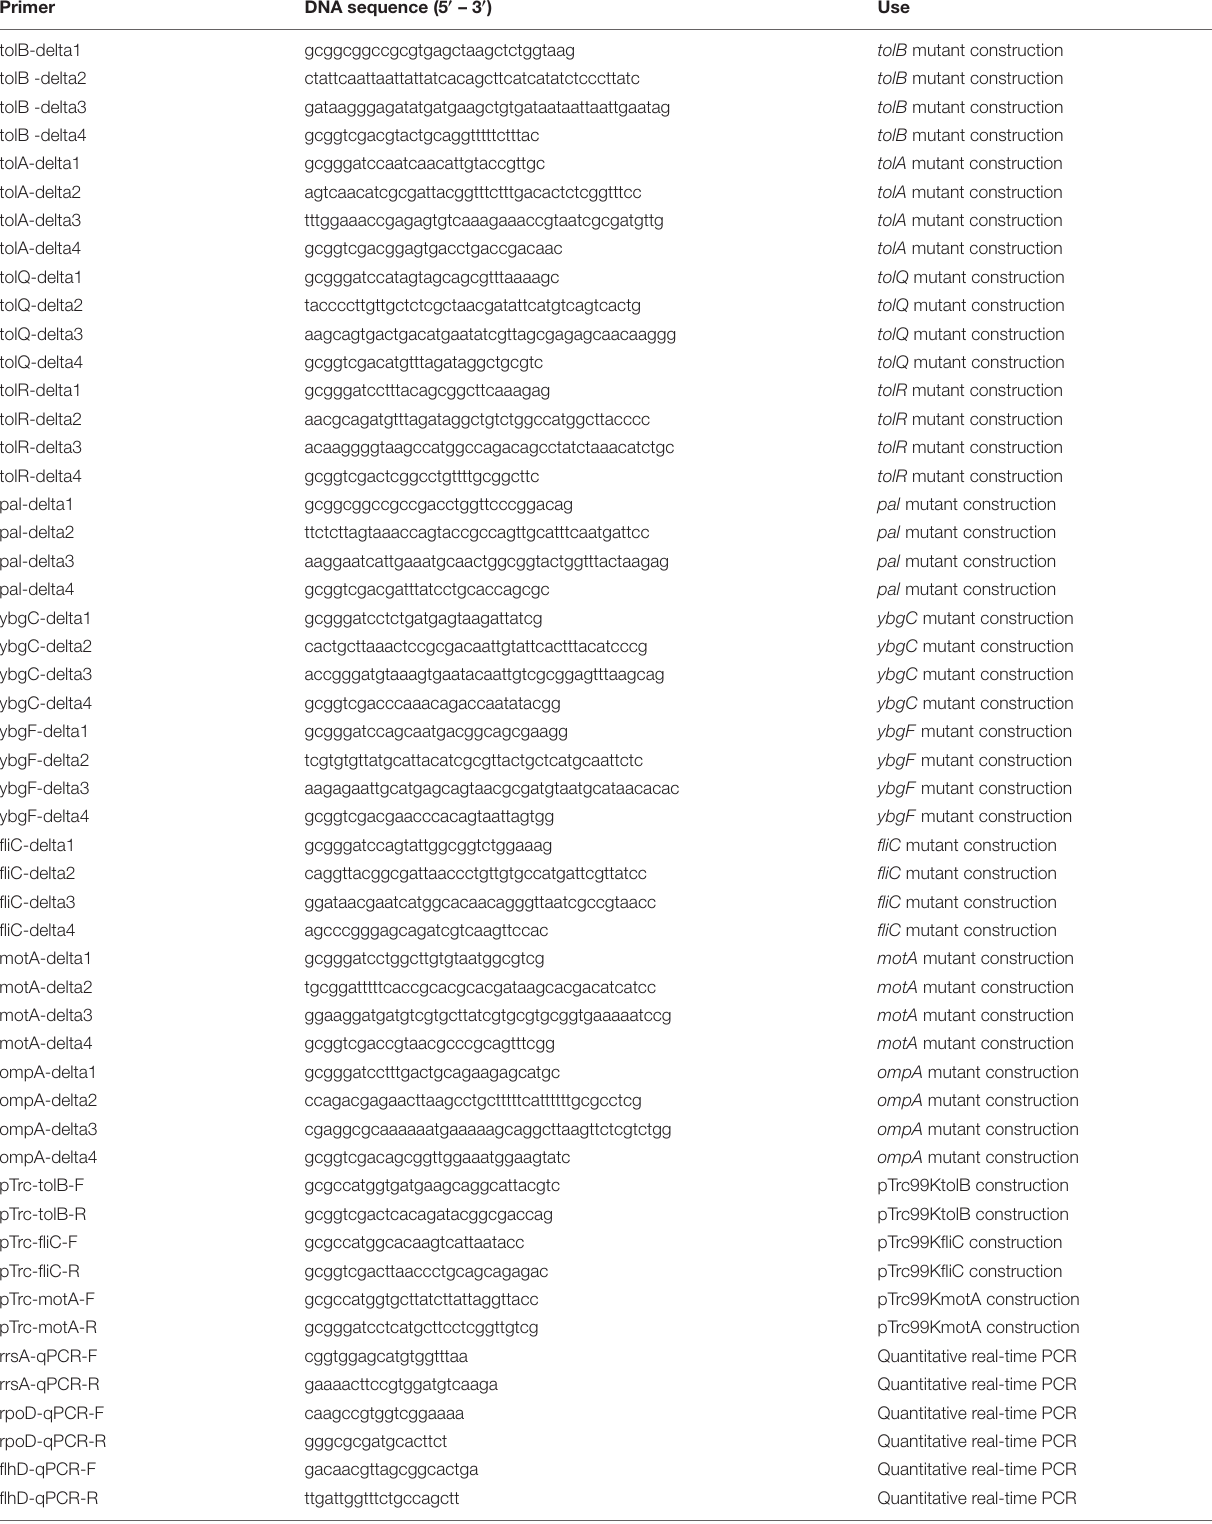
TABLE 2 | Primers used in this study. Primer DNA sequence (5 (cid:48) – 3 (cid:48)